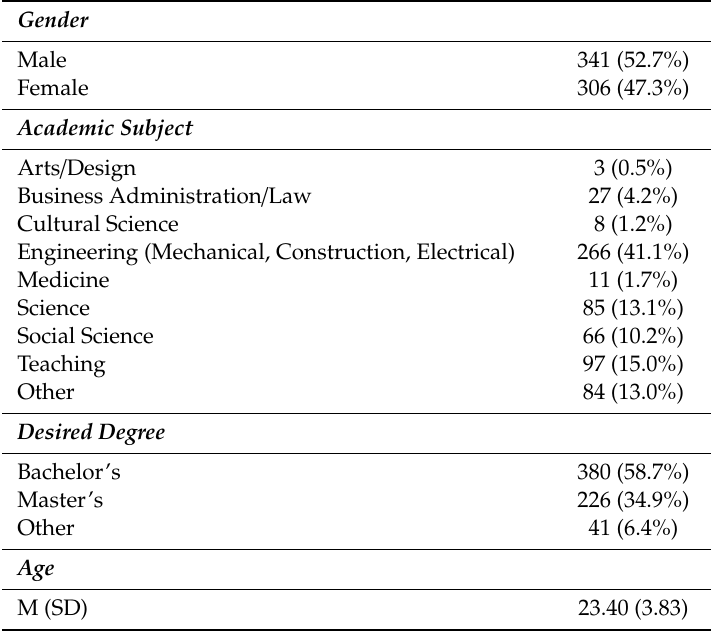
Table 2. Sociodemographic background of the